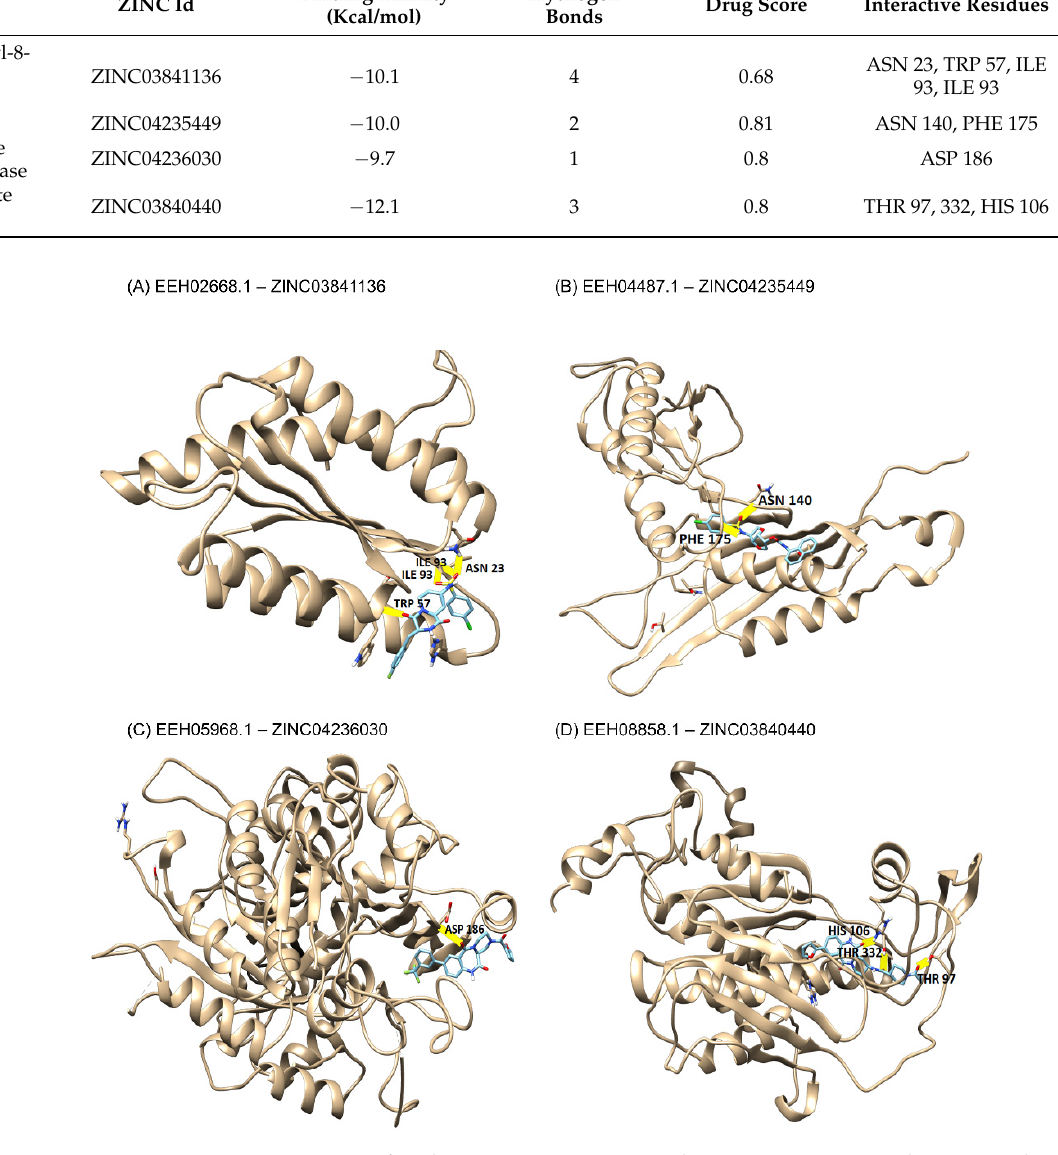
Figure 2. 3D representation of each target’s interaction with its respective natural compound. In gold is represented the 3D structure of the drug target found. In shades of blue are represented the structures of natural compounds. Between the two structures are green stripes, which represented the hydrogen bonds of each interaction and next to each are described the residues of the active site that were part of this interaction.